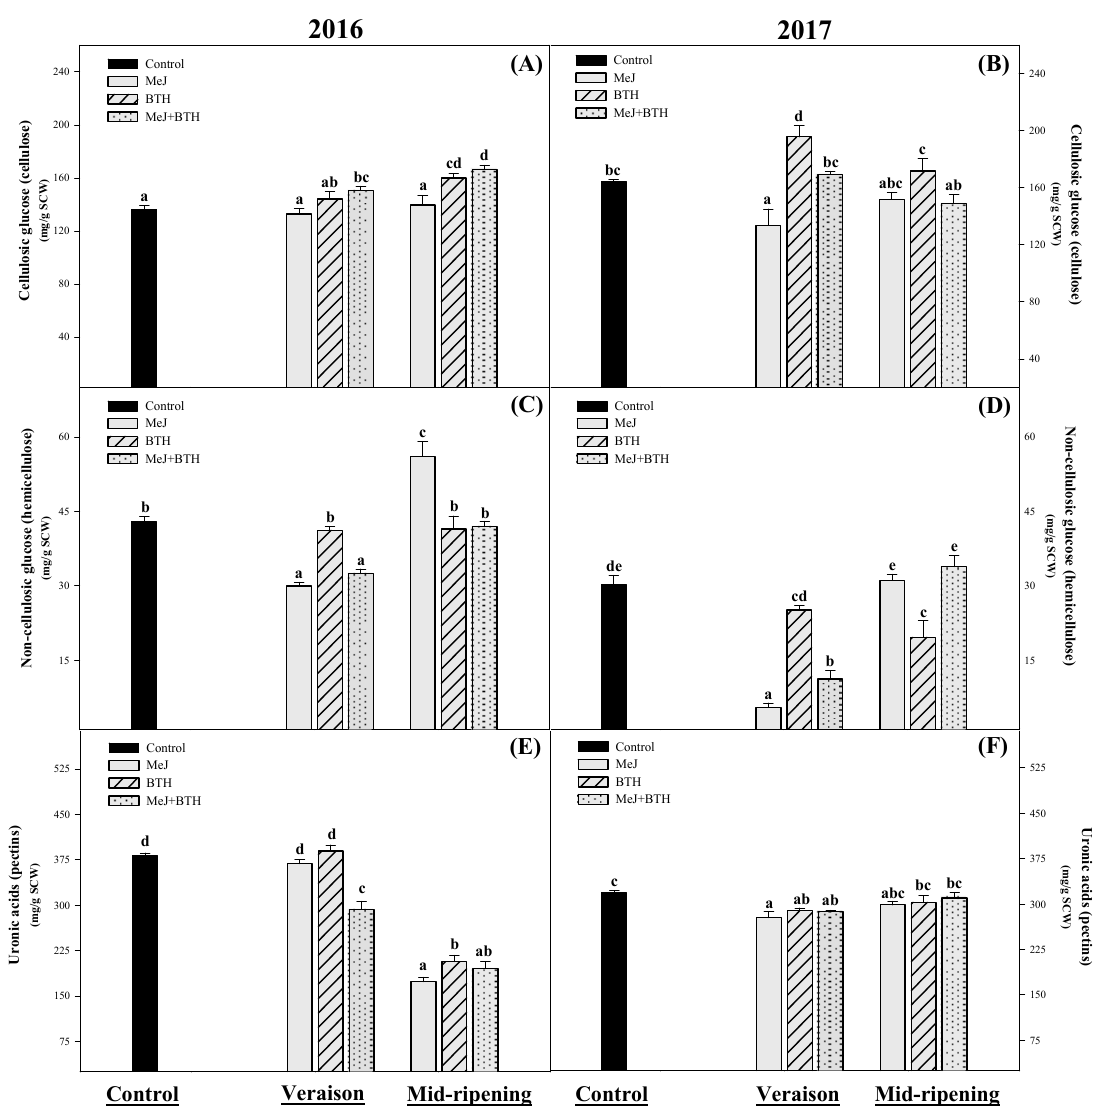
Figure 3. Concentration of cellulosic glucose ( A , B ), non-cellulosic glucose ( C , D ) and uronic acids ( E , F ) of Monastrell grape skin cell walls, during two seasons (2016 and 2017). Different letters indicate significant differences according to Duncan’s test ( p < 0.05). Abbreviations: MeJ, methyl jasmonate; BTH, benzothiadiazole.